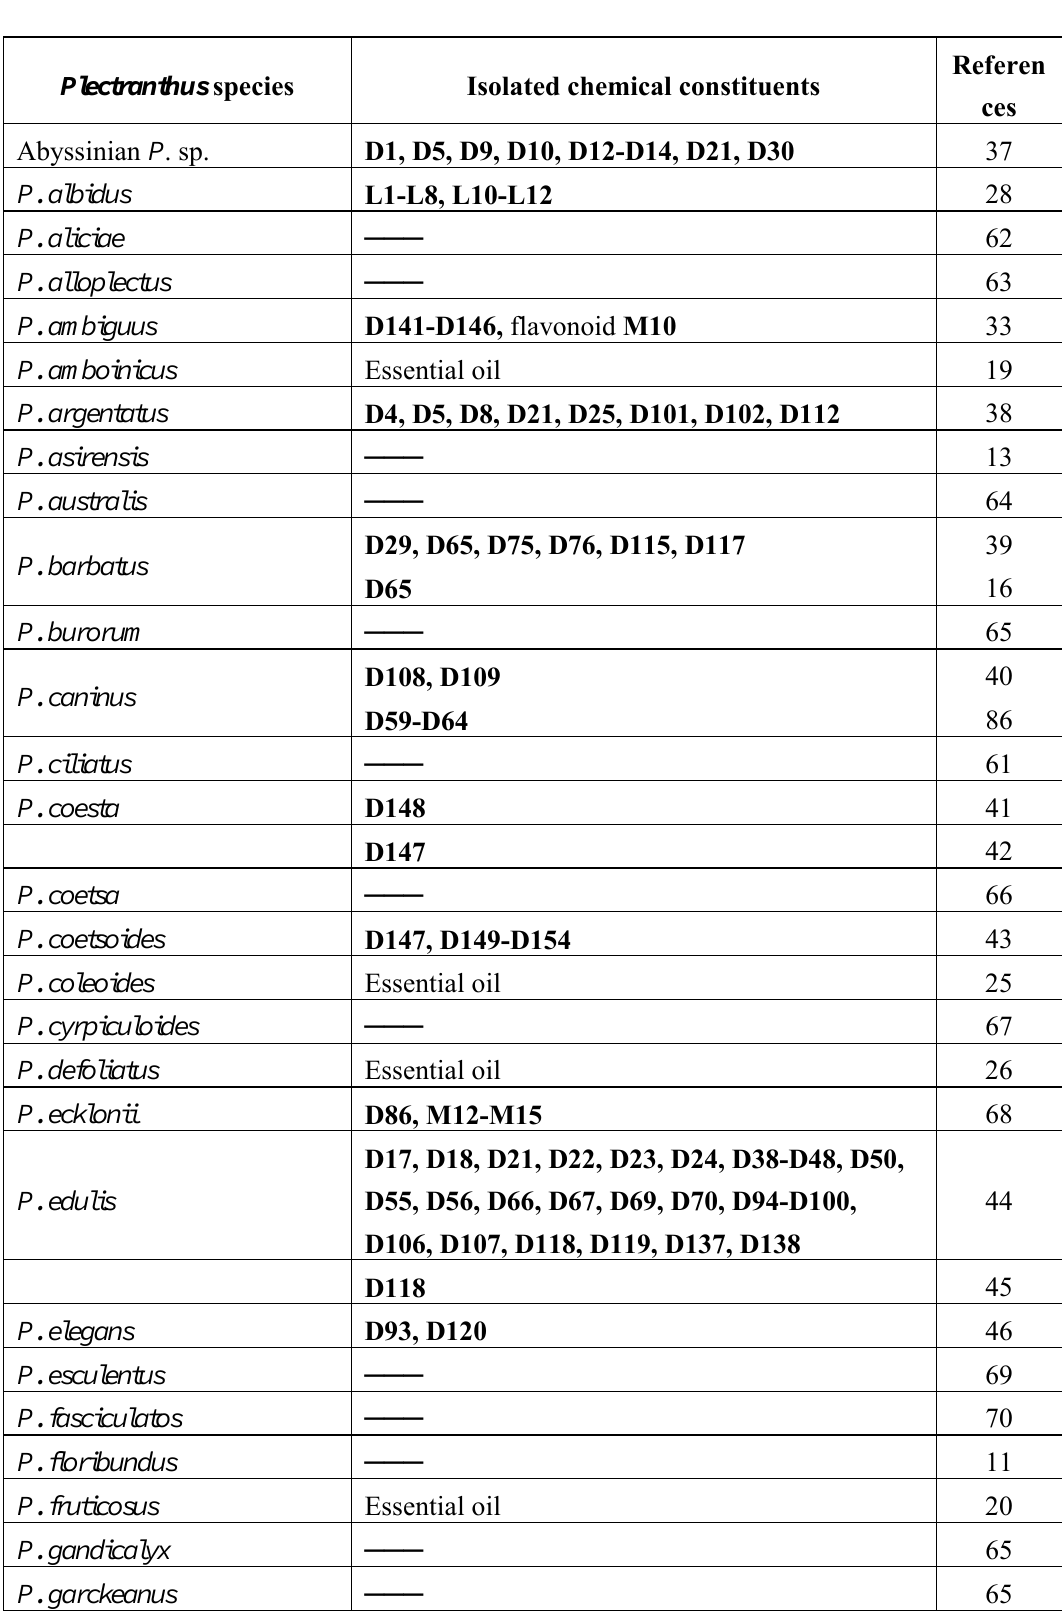
Table 1: Alphabetical list of Plectranthus species and compounds isolated from them.